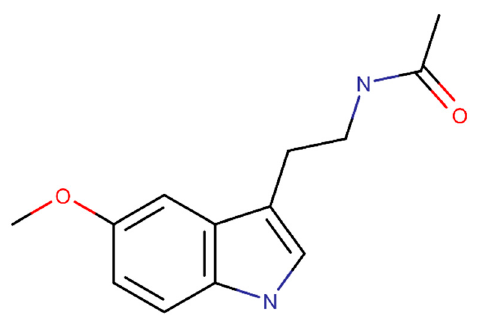
Figure 7. Chemical structure of melatonin.